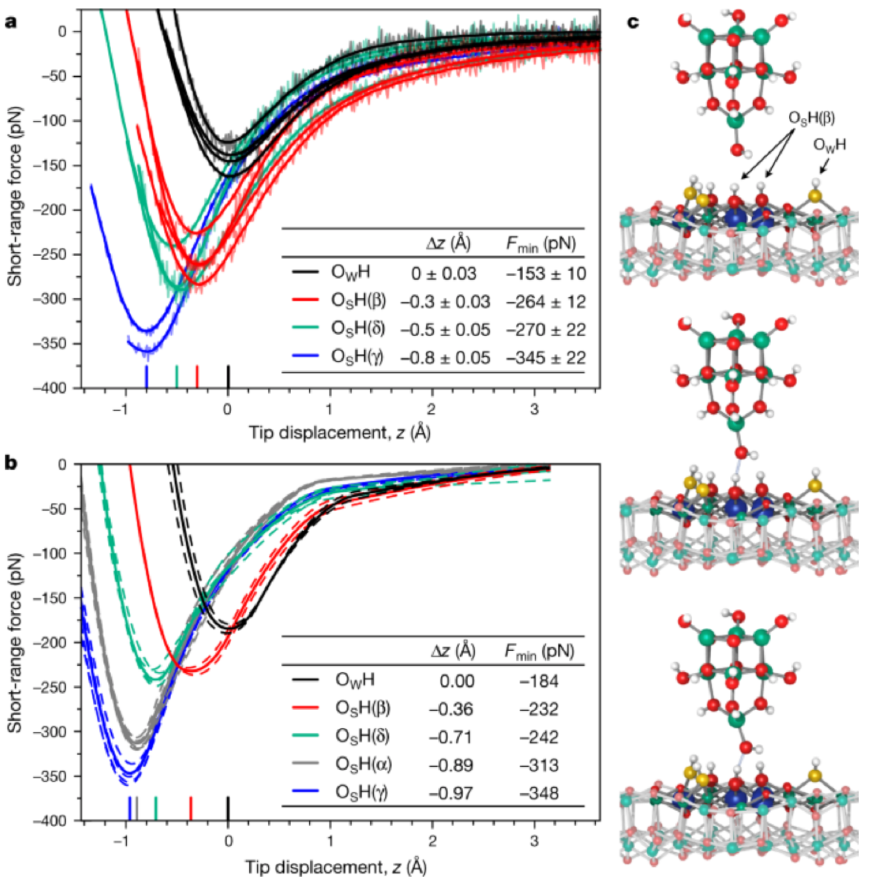
Figure 17. Probing individual surface hydroxyls with the AFM tip. ( a ) Experimental short-range force–distance curves, F ( z ) , for the OH groups initially formed on water dissociation, OWH and OSH( β ), as well as for OSH( δ ) and OSH( γ ) that were constructed by manipulation with the tip. Results from four independent datasets are shown. The tip displacement z is given with respect to the position of the OWH force curve minimum ( z = 0). The positions of the minima are indicated on the z axis for all OH groups by short coloured lines; the calculated geometric heights of the O atoms in absence of the tip are listed in Figure 3a of [80]. The errors for the force minimum (Fmin) and displacement ( ∆ z ) provided in the inset were derived using Student’s t-distribution with a confidence interval equivalent to 1 σ (68.27%). ( b ) Calculated short-range force–distance curves. Dashed curves are individual calculations for different tip orientations and sites in the unit cell (see Methods) and solid lines are the averaged curves. ( c ) Tip–sample configuration for various separations while probing an OSH( β ) group. OW, yellow; H, white; O(3c) and O(4c), red; In(6c), blue; In(5c), green. Adapted with permission from Springer Nature from Figure 2 in